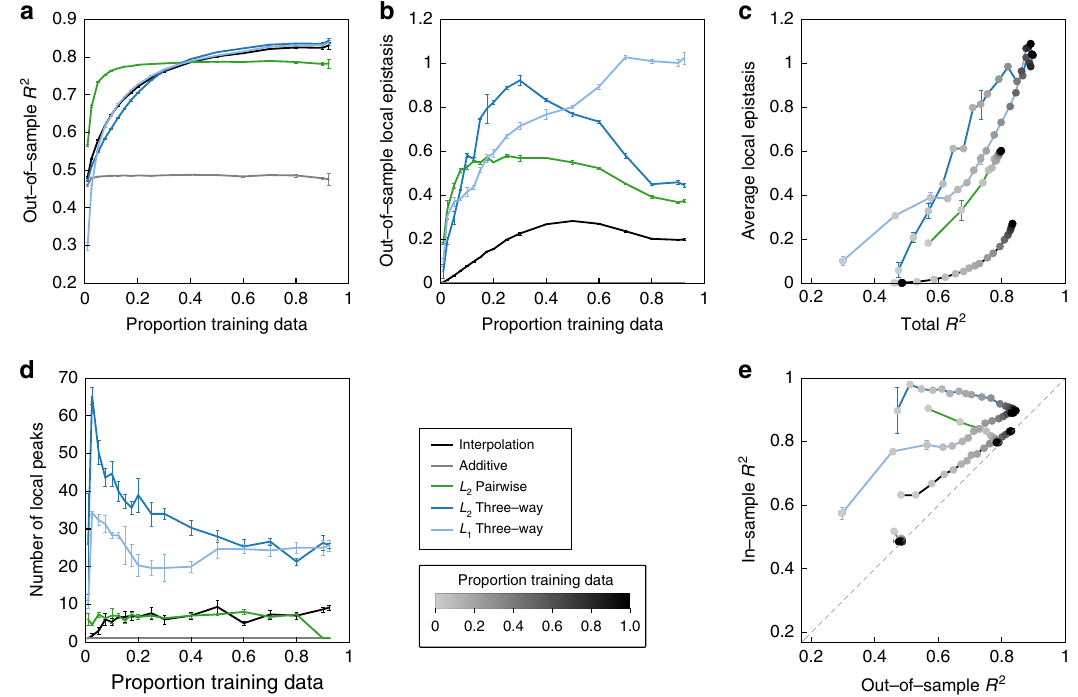
Fig. 4 Model performance for the GB1 combinatorial mutagenesis data set. Additive models were fi t using ordinary least squares. Pairwise and three- way interaction models were fi t using regularized regression with regularization parameters chosen by tenfold cross-validation (see “ Methods ” ). Points are color-coded to represent the proportion of the data randomly assigned as training. Error bars indicate one standard error around the mean. n = 3. a Predictive power (out-of-sample R 2 ) as a function of the proportion of in-sample genotypes. b Mean-squared epistasis coef fi cients between random pairs of mutations connecting out-of-sample genotypes as a function of the proportion of in-sample genotypes. c Behavior across all of sequence space (both in- sample and out-of-sample) of the fi ve models assessed using R 2 between the fi tted model and the complete data set (total R 2 ) and average local epistasis ( ϵ 2 ). Each model is represented by a curve with points corresponding to increasing proportion of the total data set assigned as training data. Note that the additive model appears at the lower left part of the plot as its total R 2 quickly stabilizes and its ϵ 2 is zero by de fi nition. d The number of local maxima of the reconstructed landscapes at different training data sizes. e Model optimism assessed by plotting in-sample R 2 vs. out-of-sample R 2